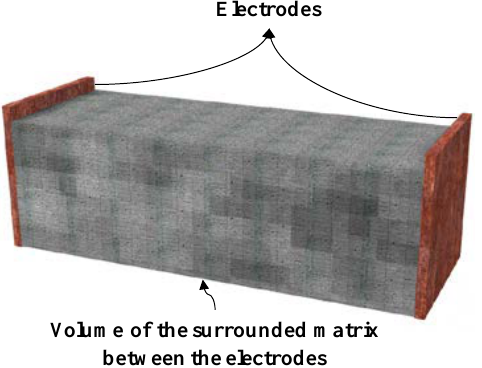
Figure 1. The volume of the surrounded matrix between the electrodes.